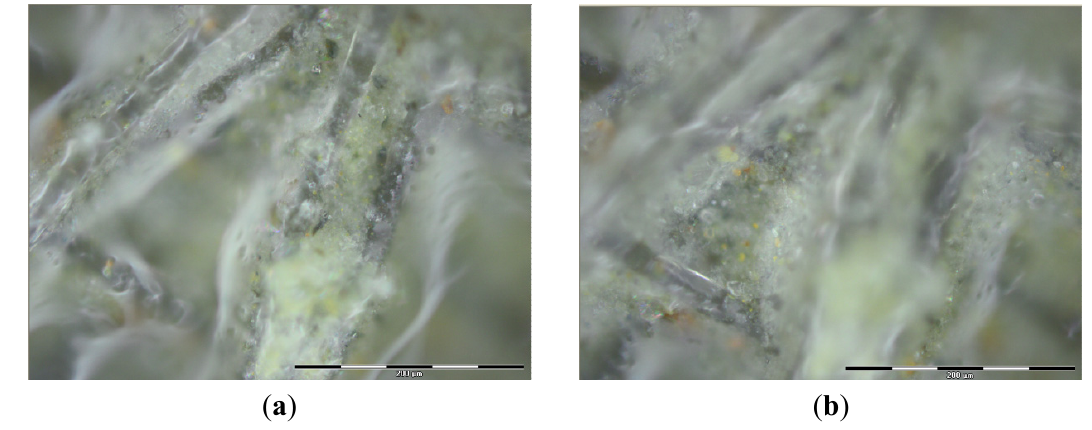
Figure 9. Filter Rig No. 3 upper geotextile layer at 20× magnification; focusing on fibres ( a ); and focusing between fibres ( b ).